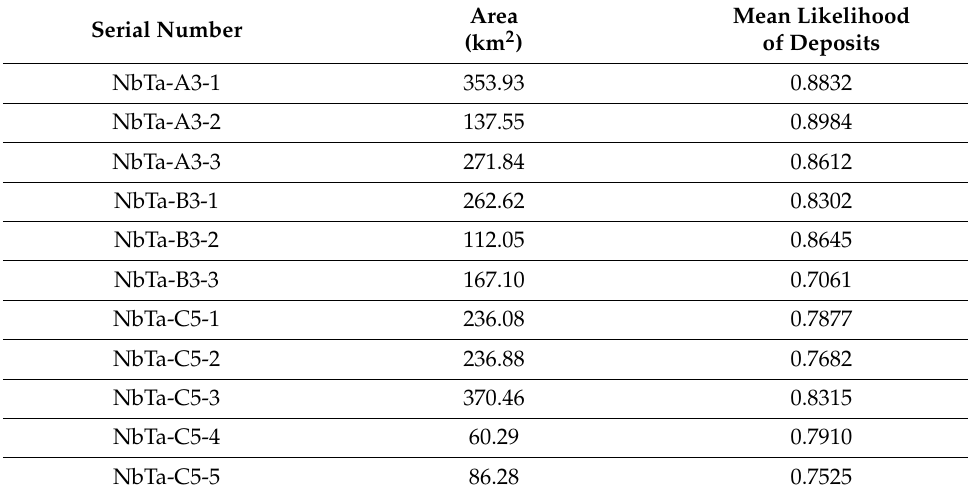
Table 11. Attributes of Nb-Ta prospective